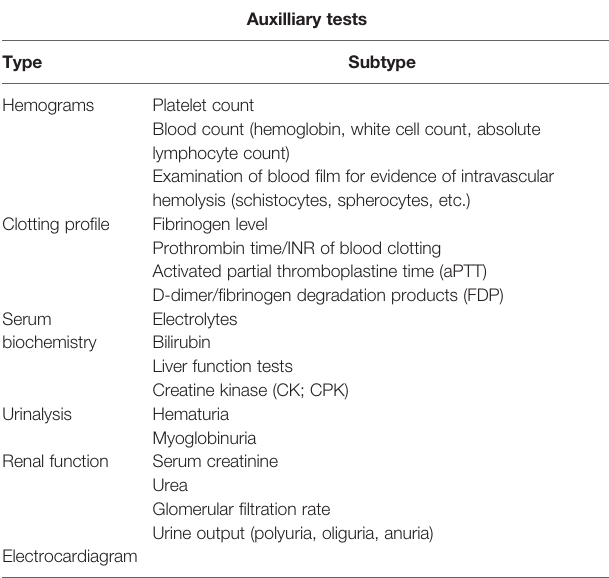
TABLE 2 | Examples of auxilliary tests that are frequently performed for suspected snakebite